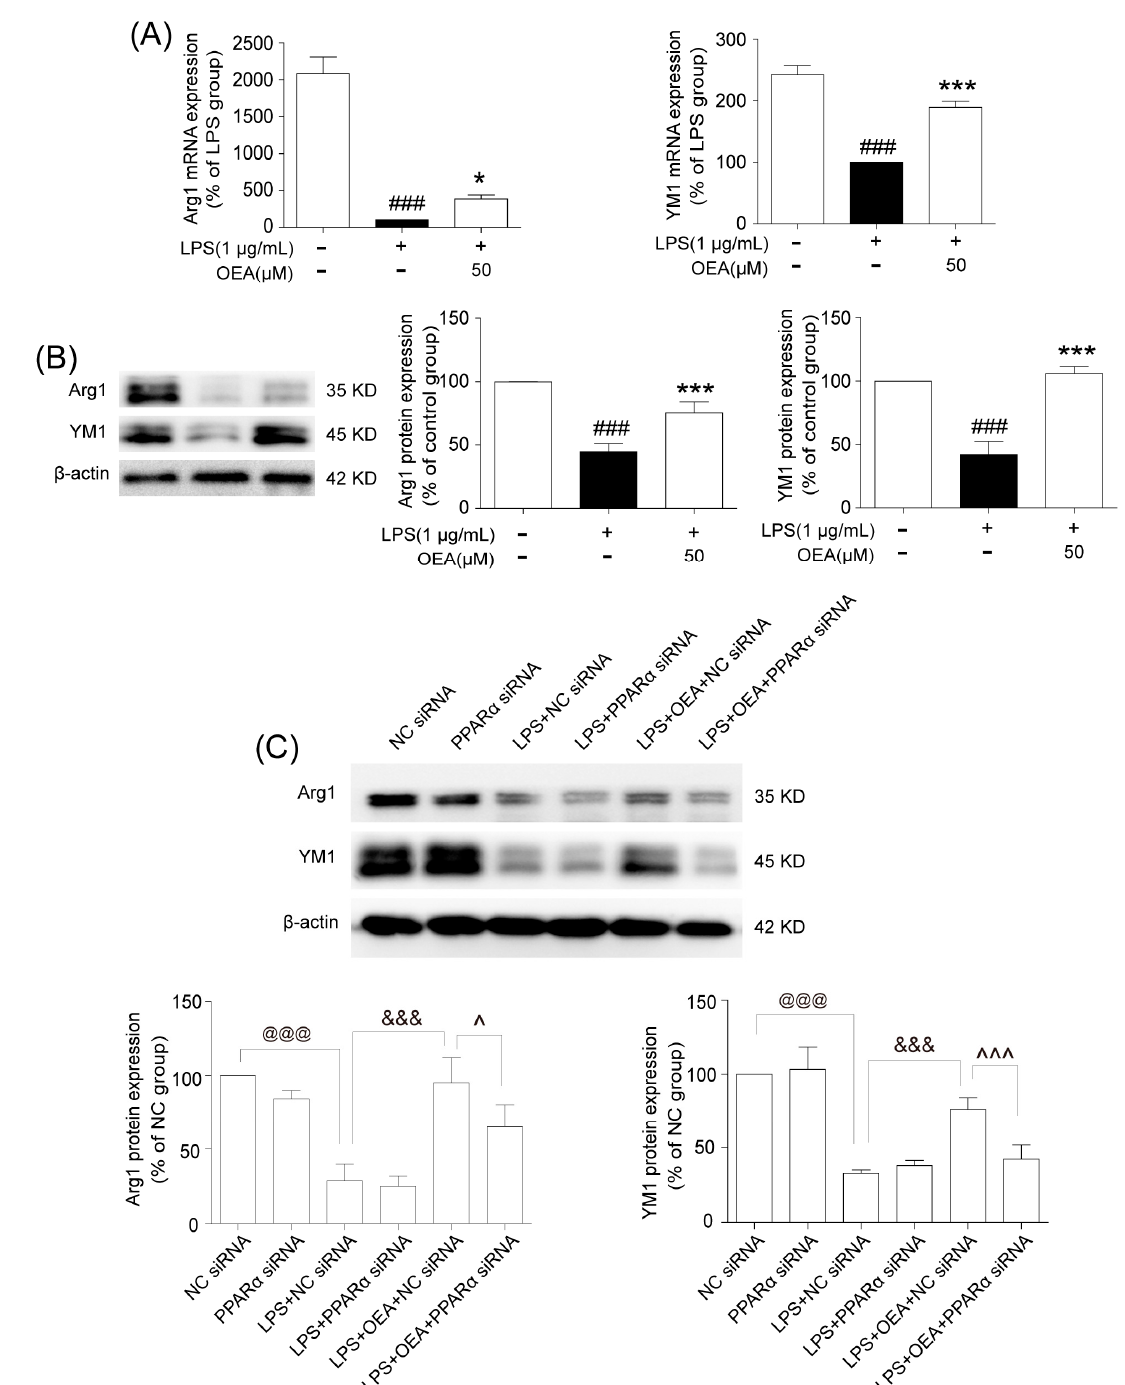
Figure 6. OEA switched microglia from an M1-like phenotype to an M2-like phenotype through a PPAR α -dependent pathway. ( A ) The effect of OEA on Arg1 and YM1 mRNA expression in LPS-induced BV2 cells. ( B ) The effect of OEA on Arg1 and YM1 protein expression in LPS-induced BV2 cells. ( C ) The knock-down of PPAR α antagonized the effect of OEA on the microglial M1-M2 shift in LPS-induced BV2 cells. The results are presented as percentages compared with the NC group, LPS group or the NC siRNA group (set to 100%). Samples were collected from five indepen- dent experiments, each performed in duplicate. The data are the means ± SEM. n = 5 per group. ### p < 0.001 vs. Control group, * p < 0.05, *** p < 0.001 vs. LPS group; @@@ p < 0.001 vs. NC siRNA; &&& p < 0.001 vs. LPS+NC siRNA; ˆ p < 0.05, ˆˆˆ p < 0.001 vs. LPS+OEA+NC